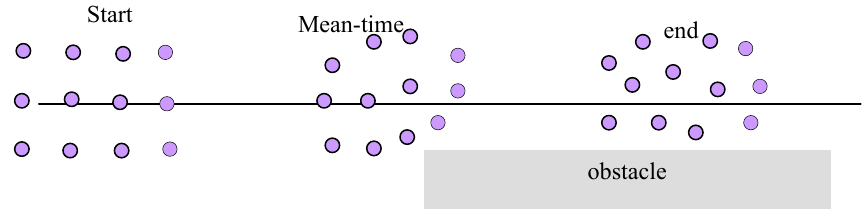
Figure 18. The result of changing the structure of a swarm of robots controlled simultaneously. Effect: No change is required.